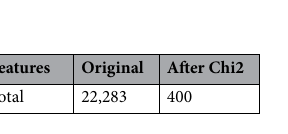
Table 3. Number of features for experiments.